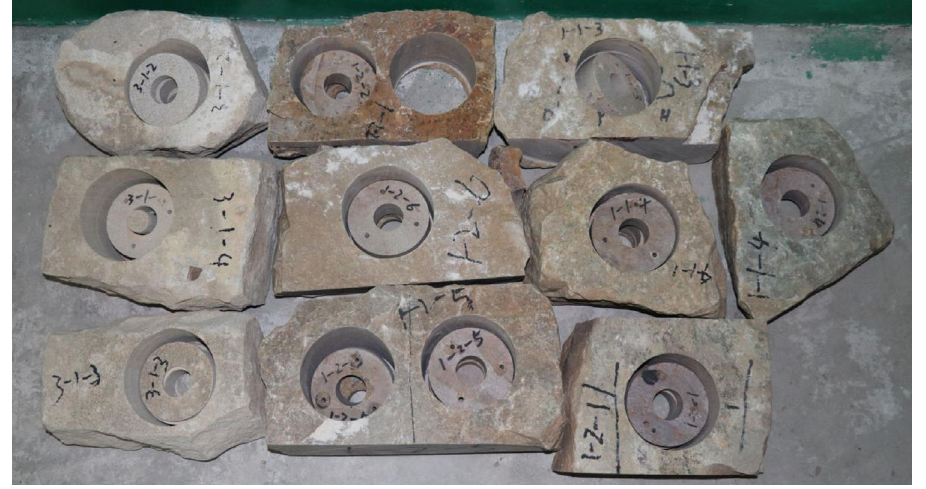
Figure 3: Test device and